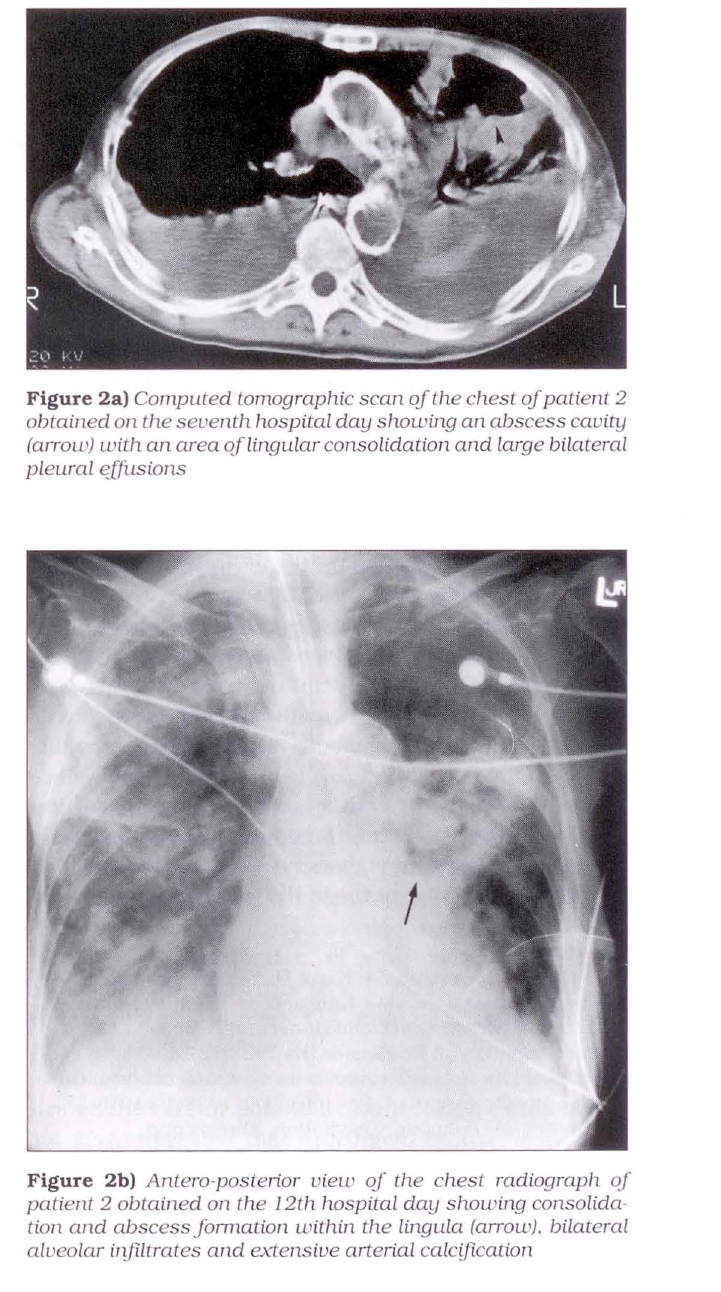
Figure 2b) Antero-posterior view of the chest radiograph of patient 2 obtained on the 12th hospital day showing